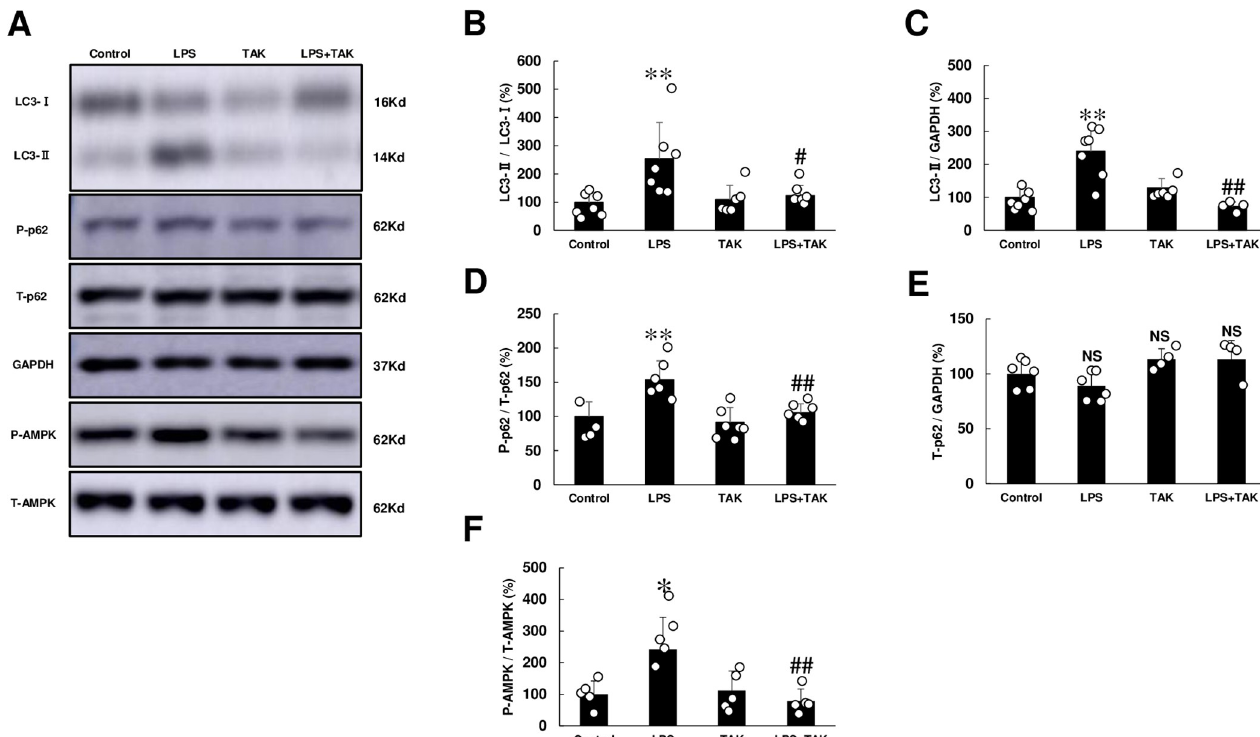
Fig 7. (A) Representative immunoblotting of LC3-I, LC3-II, phospho-p62 (Ser-351), p62, AMPK and GAPDH are shown. Full-size images of immunoblots are presented in S17-S21 Figs of S1 Data . (B) LC3-II/LC3-I was significantly increased in the PG-LPS group, and this increase was significantly attenuated by TAK-242. �� P < 0.01 vs. Control or # P < 0.05 vs. PG-LPS group by one-way ANOVA followed by the Tukey-Kramer post hoc test. (C) LC3-II expression was significantly increased in the PG-LPS group, and this increase was significantly attenuated by TAK-242. �� P < 0.01 vs. Control or # P < 0.05 vs. PG-LPS group by one-way ANOVA followed by the Tukey-Kramer post hoc test. (D) p62 phosphorylation (Ser-351) was significantly increased in the PG-LPS group, and this increase was significantly attenuated by TAK-242. �� P < 0.01 vs. Control or # P < 0.05 vs. PG-LPS group by one-way ANOVA followed by the Tukey-Kramer post hoc test. (E) p62 expression was similar among the four groups. NS, not significantly different from the Control ( P > 0.05) by one-way ANOVA followed by the Tukey-Kramer post hoc test. (F) AMPK (Thr-172) was significantly increased in the PG-LPS group, and this increase was significantly attenuated by TAK-242. � P < 0.05 vs. Control or ## P < 0.01 vs. PG-LPS group by one-way ANOVA followed by the Tukey-Kramer post hoc test. Data are means ± SD and representative immunoblots are shown. Data shows means ± SD and scattered dots show individual